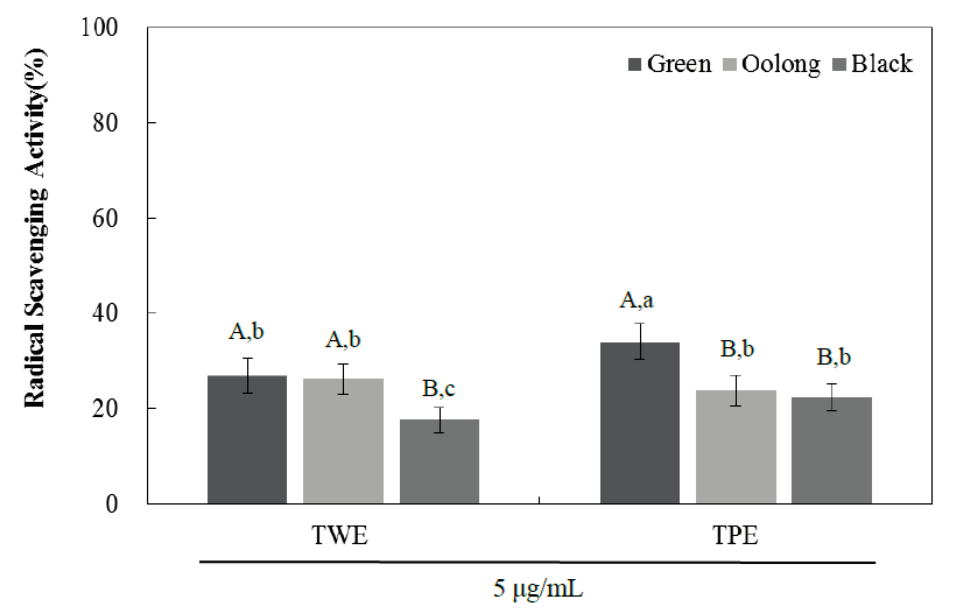
Figure 3. The DPPH radical scavenging activities of tea water extract (TWE) and tea pomace extract (TPE) of green, oolong, and black tea at a concentration of 5.0 µg/mL. The absorbance was measured at 517 nm, and the results were expressed as mean ± SD with three independent experiments in triplicate. Different corresponding letters indicate significant differences at p < 0.05 by Duncan’s test. A,B The first letters in uppercase are different among types of tea within same extraction method and a − c the second letters in lowercase indicate significant differences among all